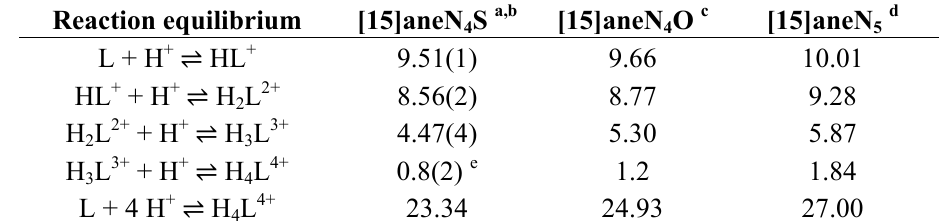
K ) of [15]aneN S and similar 4 i